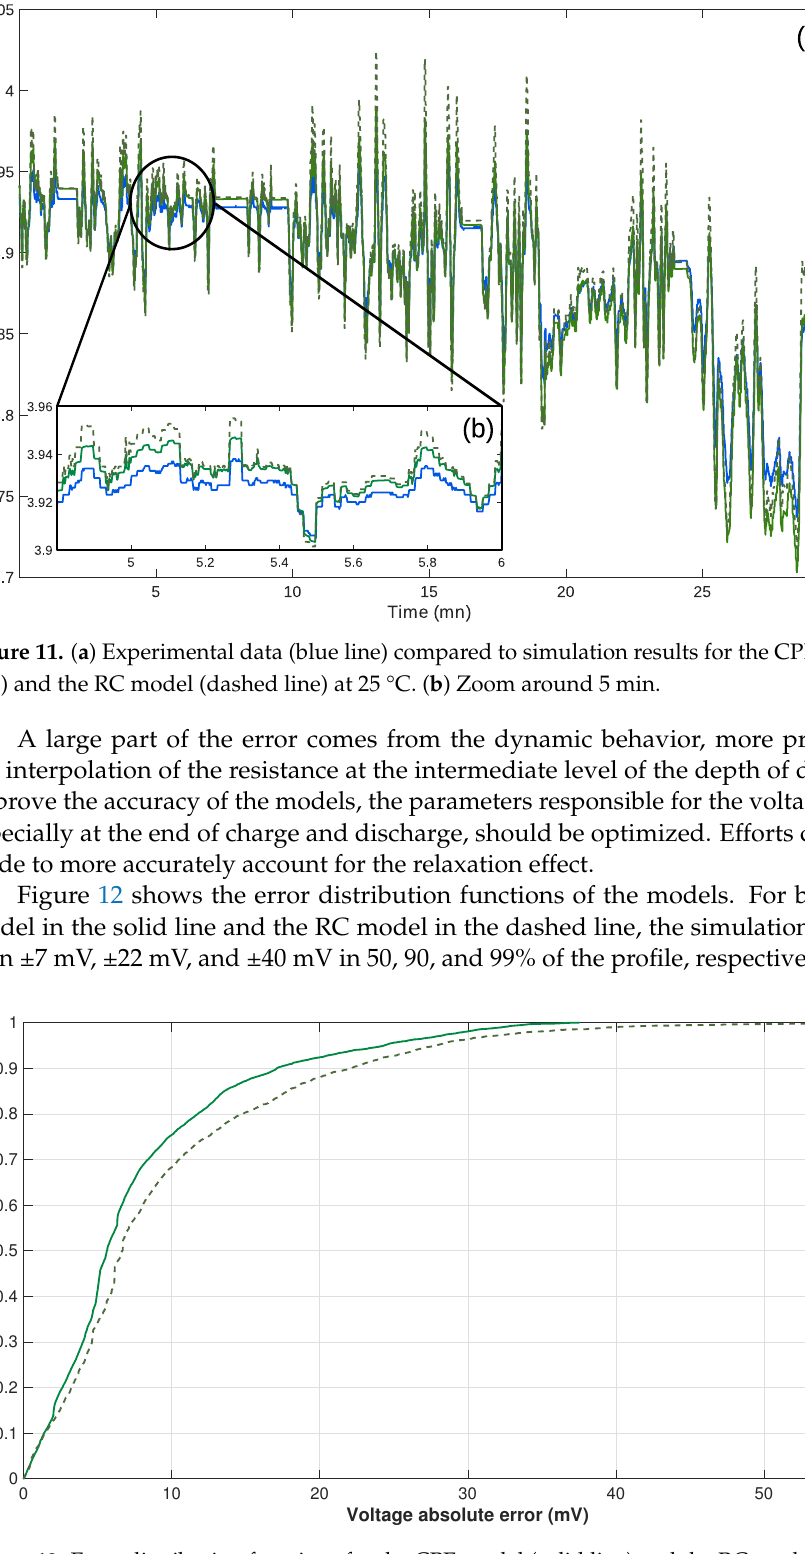
Figure 12. Error distribution functions for the CPE model (solid line) and the RC model (dashed line) emulating a cell voltage response used with a WLTC profile at 25